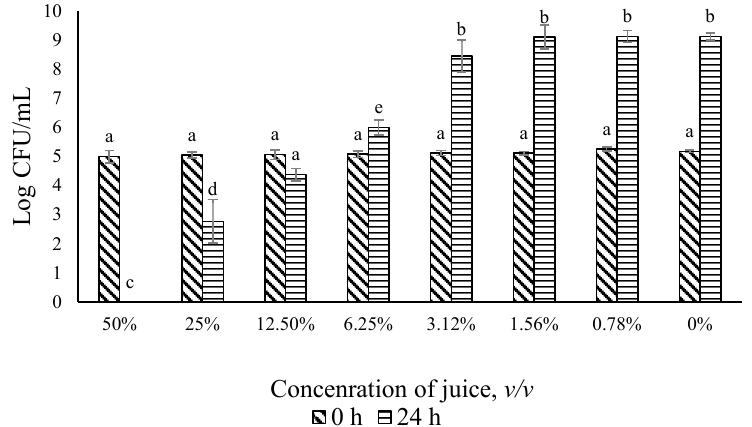
Figure 1. Evaluation of the antimicrobial effect of ohelo berry juice on Listeria monocytogenes . The viable cell counts of diluted ohelo berry juice in Mueller–Hinton broth were determined at 0 and 24 h. Means with different letters (a through e) are significantly different at p < 0.05.